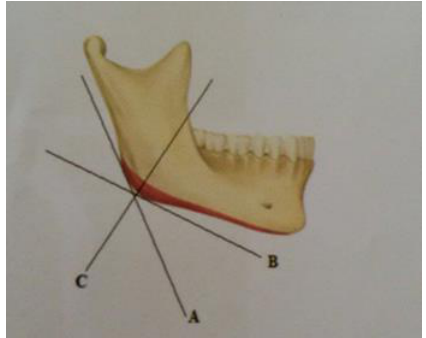
Fig 3: showing the measurement of cortical thickness and BMD in Gonial angle. A- tangential line to the distal border of ramus B- tangential line to the bottom of mandible C- Bisecting of the angle between A and B.